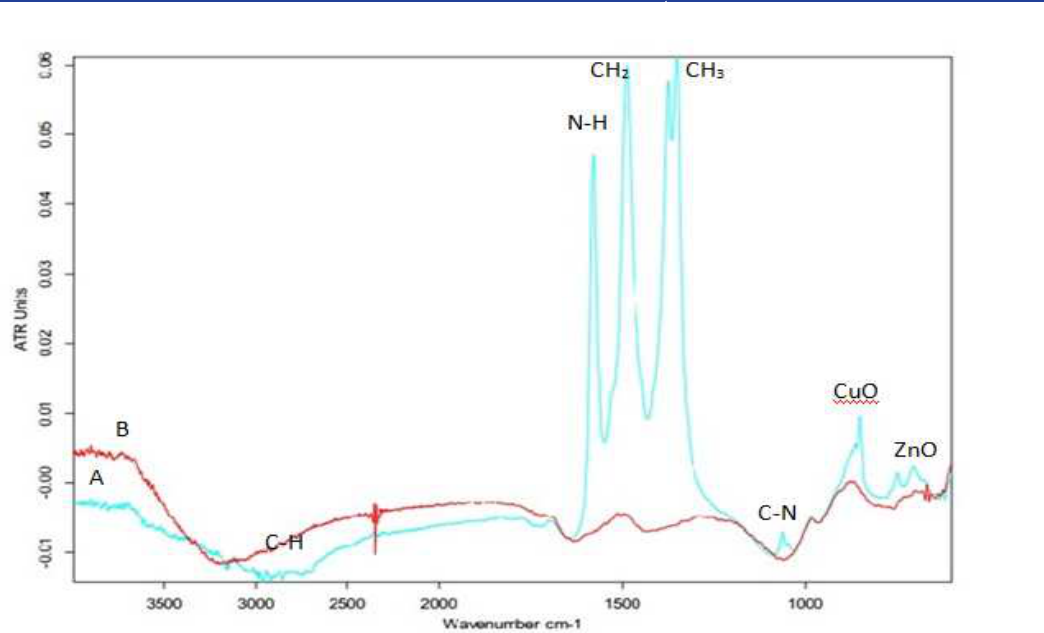
Figure 3. Fourier transform infrared spectrum of in situ surface modified zinc oxide doped copper using 1 ml triethylamine